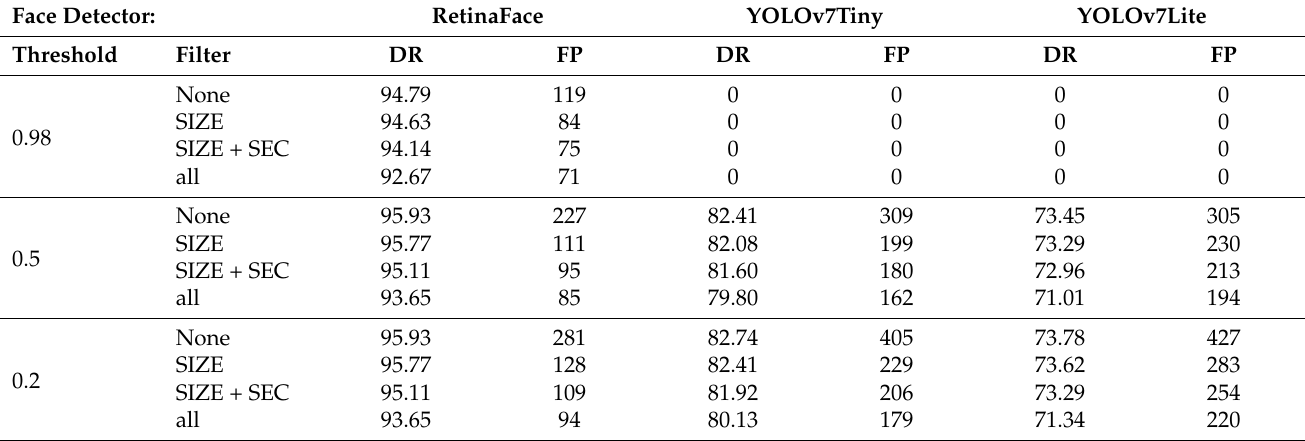
Table 3. Performance of face detection methods combined by filtering